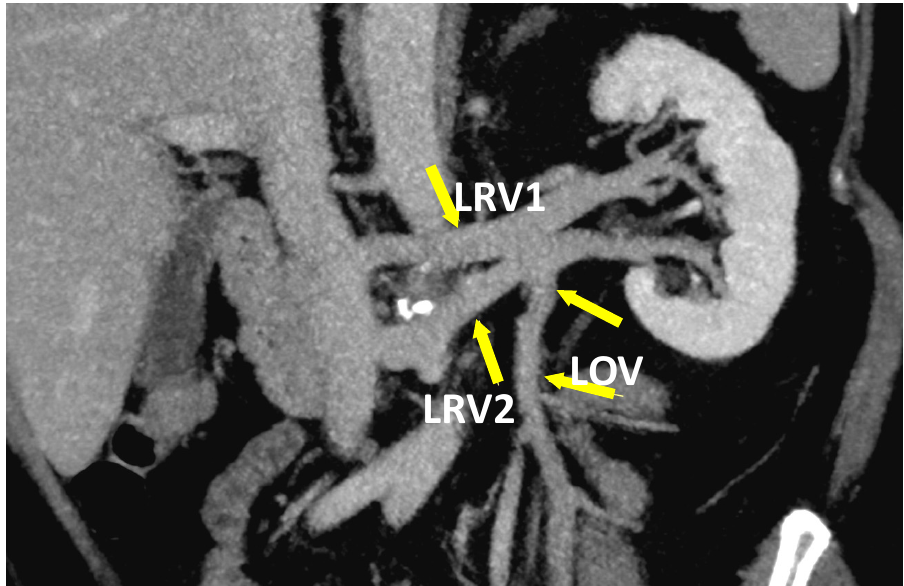
Figure 6. The coronal plane of CT-V scan in patient with duplicated LRV (LRV1 and LRV2). Blood from LOV is drained into LRV2.